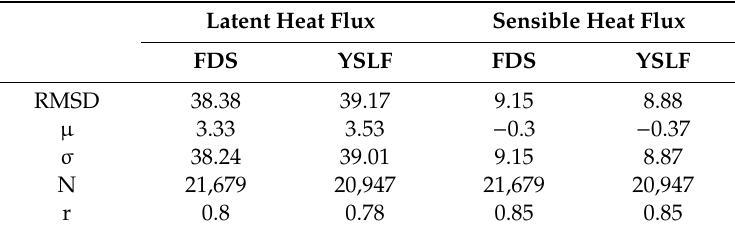
Figure 6. Two dimensional ‐ density plot of collocated CYGNSS and Buoy surface latent ( a , c ) and sensible ( b , d ) surface heat fluxes. Comparisons for both versions of CYGNSS Fluxes (top: Fully Developed Seas, bottom: Young Seas with Limited Fetch). The diagonal gray line is the 1:1 agreement. Table 1. Statistical parameters, calculated from the density scatter plots in Figure 6, between the CYGNSS and buoy flux data. RMSD: root mean square difference (CYGNSS ‐ Buoy) [W/m 2 ]; μ : mean bias [W/m 2 ]; σ : standard deviation of the difference [W/m 2 ]; N: total sample size; and r: correlation coefficient.